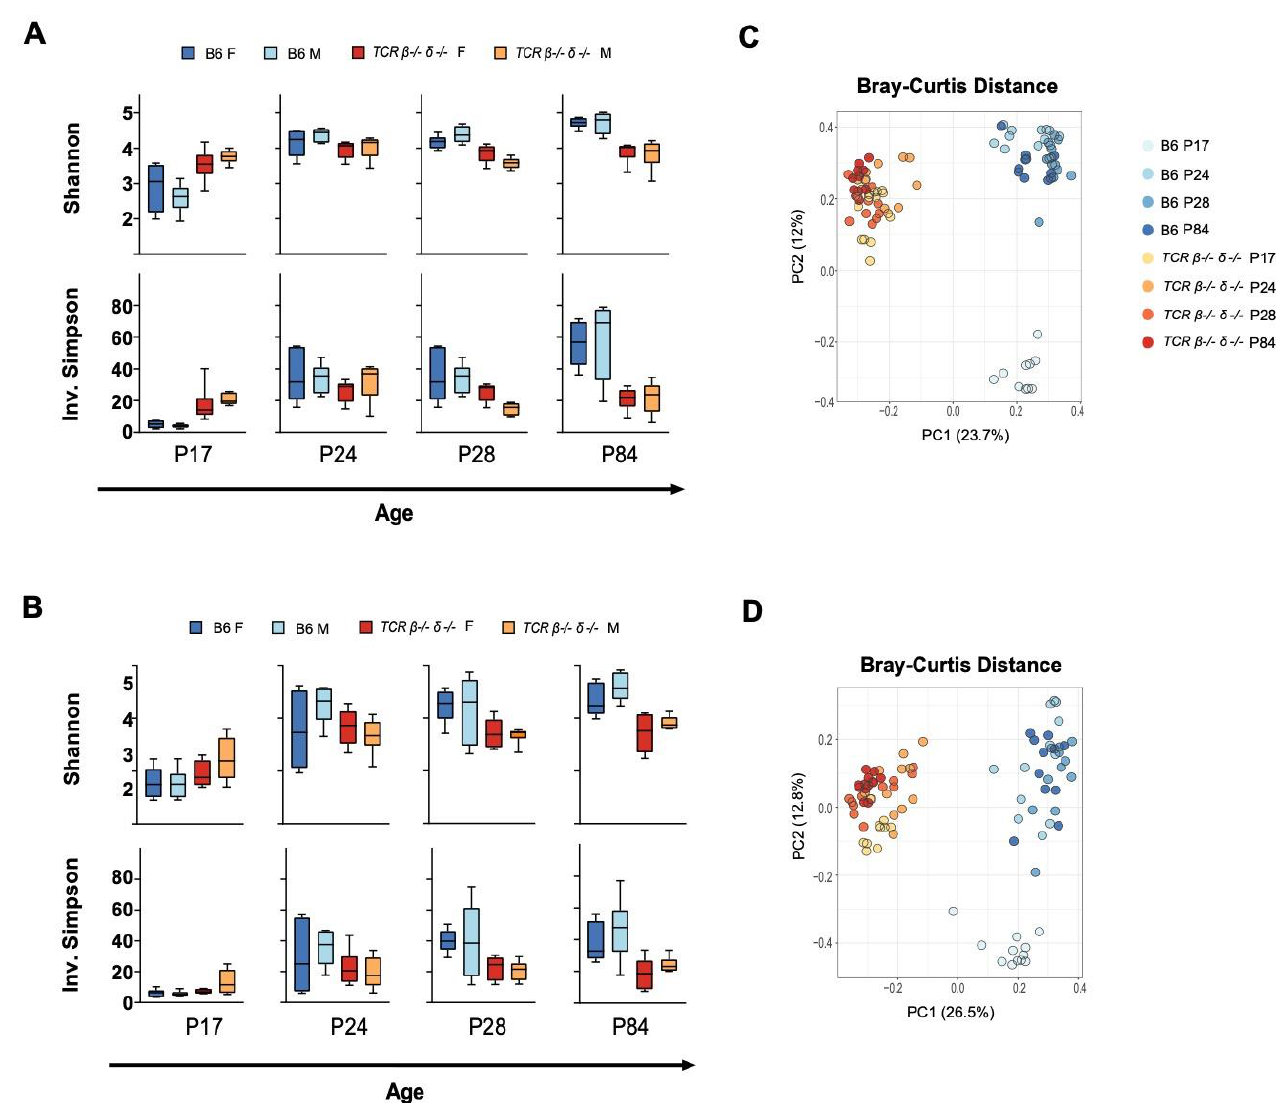
Figure 1. Developmental changes in alpha and beta diversity of cecal and fecal samples in T cell receptor double knock-out ( TCR β –/– δ –/–) and C57Bl6 (B6) mice. Shannon and Inverse Simpson indices were used to calculate alpha diversity for each genotype, age and sex ( n = 6 per genotype/age/sex). Min-max boxplots comparing alpha diversity metrics across timepoints for cecal and fecal samples are shown in ( A , B ), respectively. For both cecal and fecal samples, alpha diversity at P17 was higher in TCR β –/– δ –/– than in B6 mice (Shannon fecal p = 0.029, cecal p = 0.0005, Simpson fecal p = 0.029, cecal p < 0.0001). This trend reversed at following timepoints (P24, pre-puberty to 12 weeks, adulthood), with TCR β –/– δ –/– mice exhibiting lower alpha diversity than B6 mice (P24 Shannon fecal p = 0.133, cecal p = 0.038, Simpson fecal p = 0.08, cecal p = 0.39; P28 Shannon fecal p = 0.007, cecal p = 0.0002, Simpson fecal p = 0.007, cecal p = 0.0019; P84 Shannon fecal p = 0.0001, cecal p < 0.0001, Simpson fecal p = 0.0011, cecal p = 0.0002). Sex differences were not observed in alpha diversity. Principal component analysis (PCA) decomposition of Bray-Curtis dissimilarity between samples is shown in ( C ) (cecal) and ( D ) (fecal). Samples collected from B6 mice at P17 show strong clustering and separation from later timepoints, a temporal pattern not observed in the microbiota of TCR β –/– δ –/– mice. A significant main effect of genotype was found for both fecal and cecal samples and for all timepoints ( p <